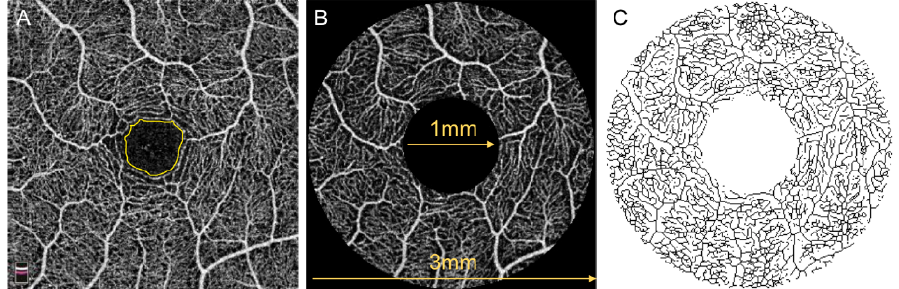
Figure 3. Schematic of OCTA parameters. ( A ) Full retinal thickness OCTA image of a healthy control showing the foveal avascular zone (FAZ) outlined in yellow. The FAZ was used to establish the background threshold for both vessel length density (VLD) and adjusted flow index. ( B ) Superficial capillary plexus (SCP) angiogram of the same individual showing delineation of the parafovea area between two rings of 1 mm and 3 mm in diameter. All OCTA parameters were obtained for the parafovea. ( C ) Skeletonized SCP image for the calculation of vessel length density (VLD) after binarization based on a threshold determined by the FAZ and subsequent skeletonization of all vessels to 1 ‐ pixel wide.